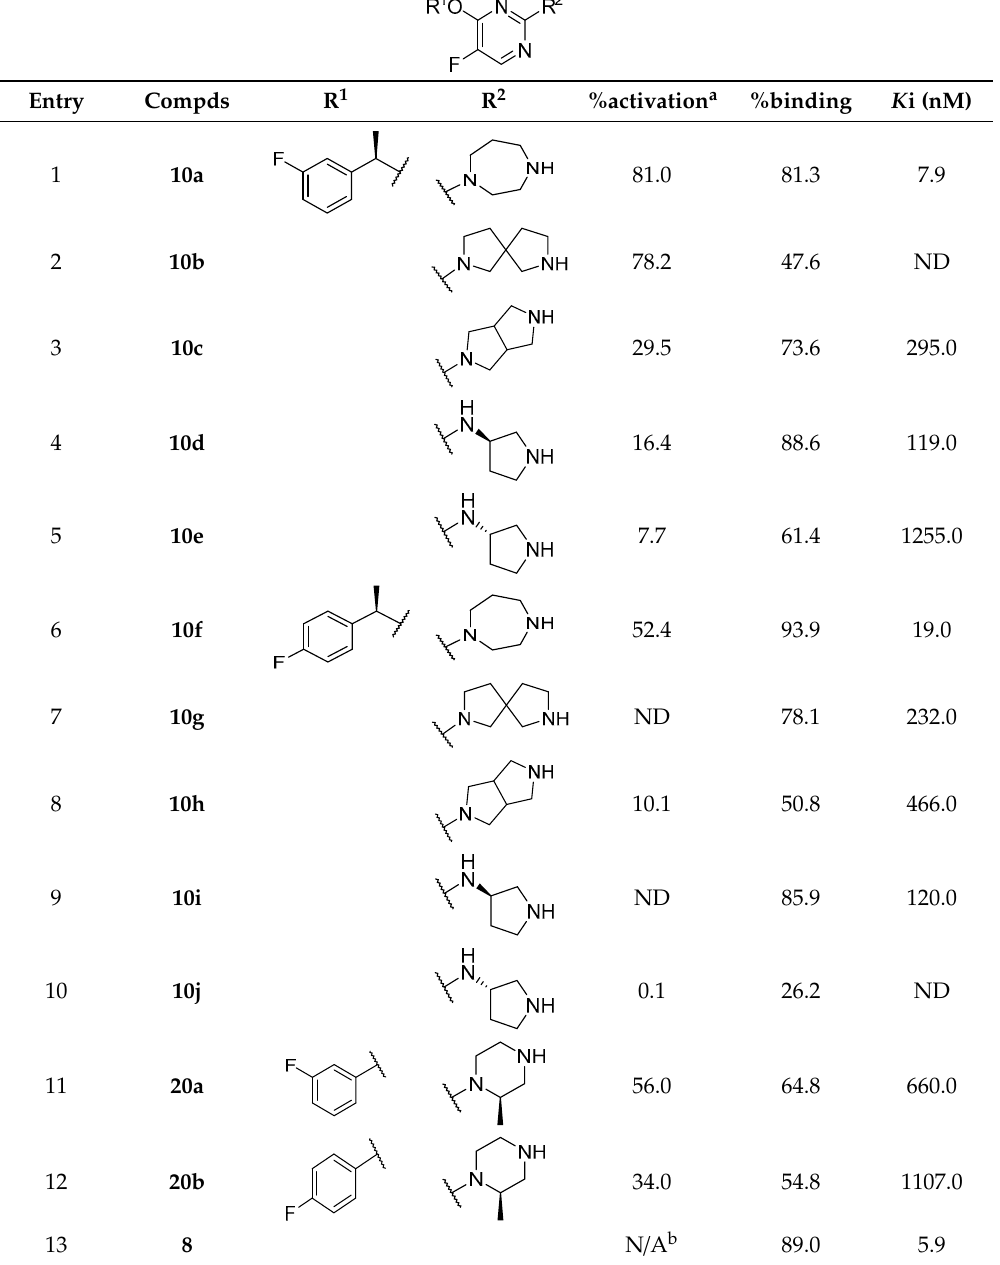
Molecules 2019 , 24 , x FOR PEER REVIEW Table 2. In vitro activity of 2,4-disubsitutued pyrimidine against 5-HT 2C. Table 2. In vitro activity of 2,4-disubsitutued pyrimidine against 5-HT 2C. Table 2. In vitro activity of 2,4-disubsitutued pyrimidine against 5-HT 2C. Table 2. In vitro activity of 2,4-disubsitutued pyrimidine against 5-HT 2C. Table 2. In vitro activity of 2,4-disubsitutued pyrimidine against 5-HT Table 2. In vitro activity of 2,4-disubsitutued pyrimidine against 5-HT 2C.